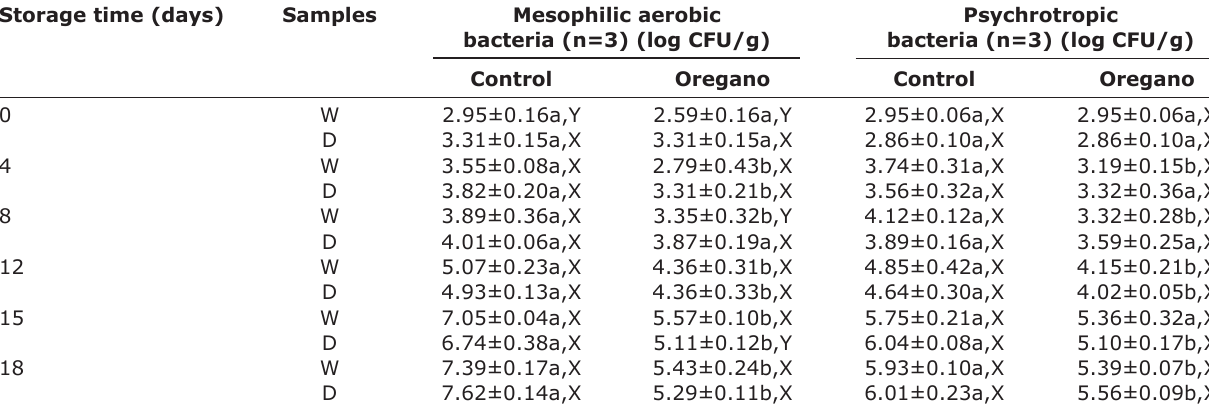
Table-3: Effect of oregano extract with vacuum-packaging on the mesophilic and psychrophilic bacterial counts in white (W) and dark (D) muscles of frigate tuna fillets stored at refrigerated (3±1°C) conditions. Storage time